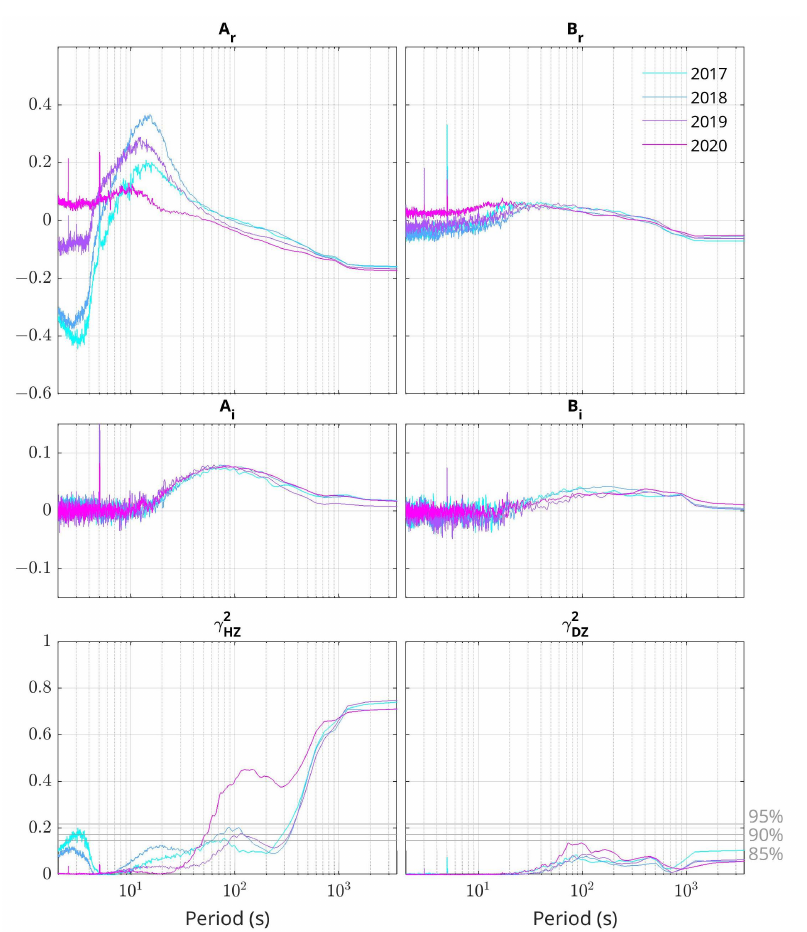
Figure 4. Transfer functions at LMP for the pairs HZ ( left ) and DZ ( right ) in both real ( r ) and imaginary ( i ) parts. Bottom panels report the ordinary (univariate) coherences between vertical and horizontal components. In the bottom panels, the coherence thresholds at 85, 90 and 95%, estimated by a Monte Carlo method, are shown as horizontal gray